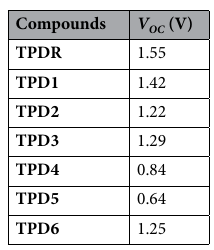
Table 5. Open circuit voltage and energy driving force of the entitled compounds.